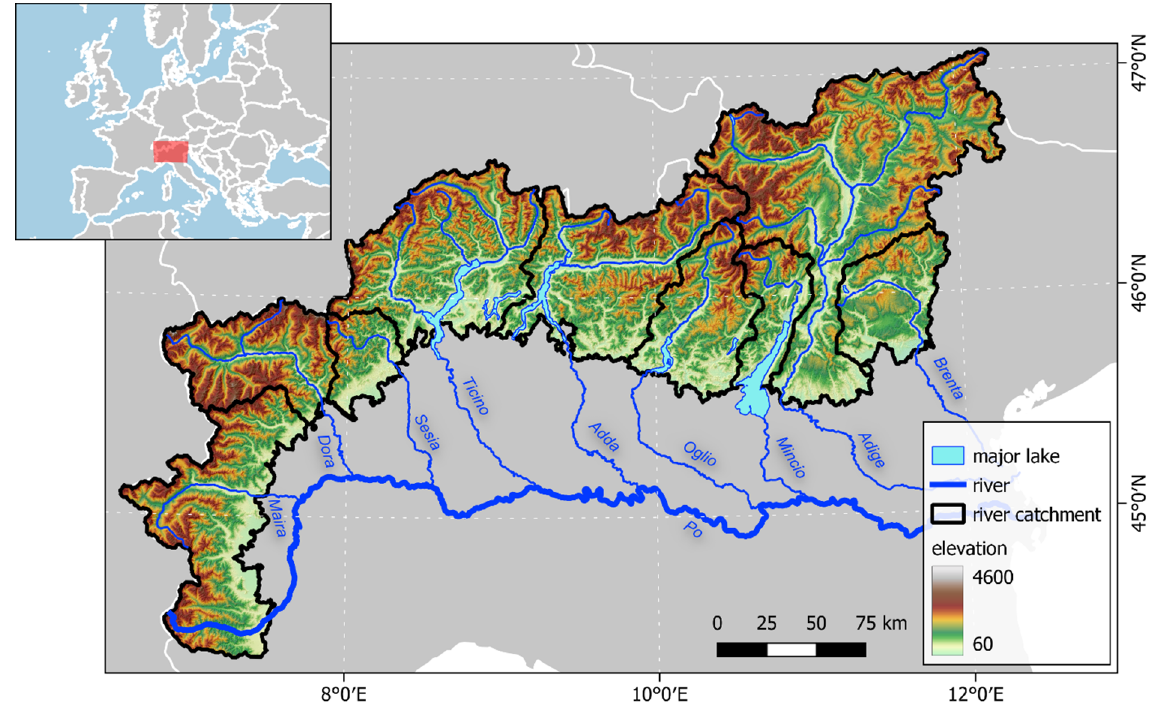
Figure 1. Location and topography of the Alpine reaches of the nine Italian catchments analyzed in this study.